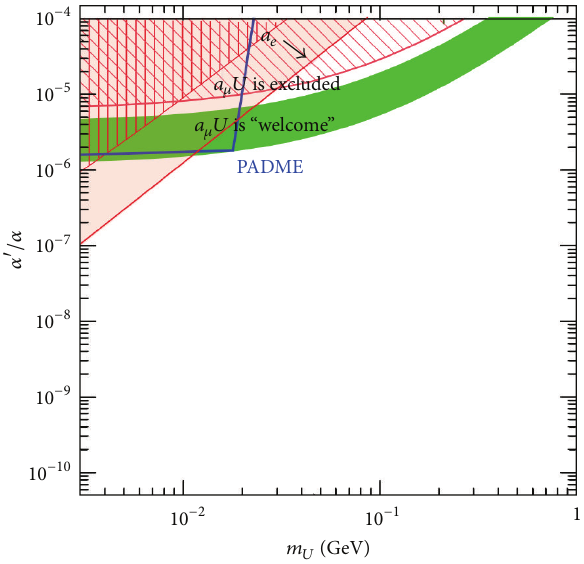
Figure 21: Expected exclusions in the invisible channel compared with the band of values preferred by current 𝑔 𝜇 − 2